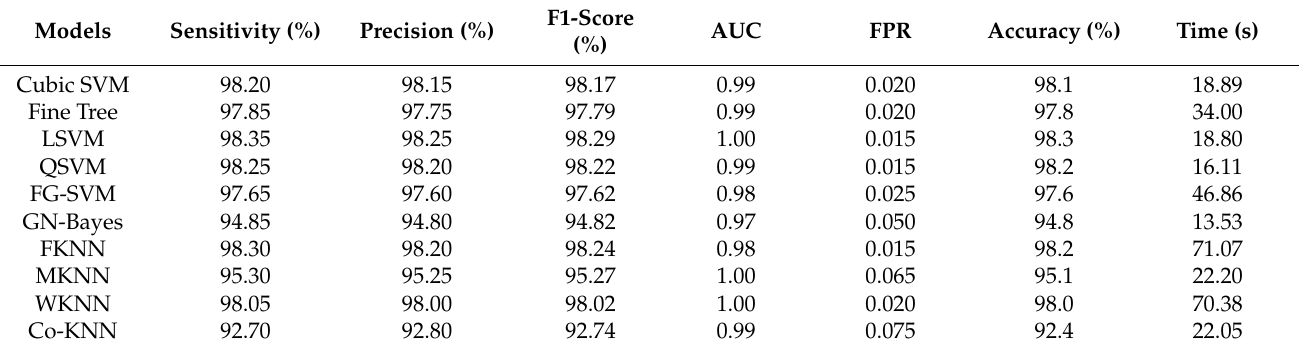
Table 14. Classification results using Fine-tuned MobilenetV2 deep features for INbreast.